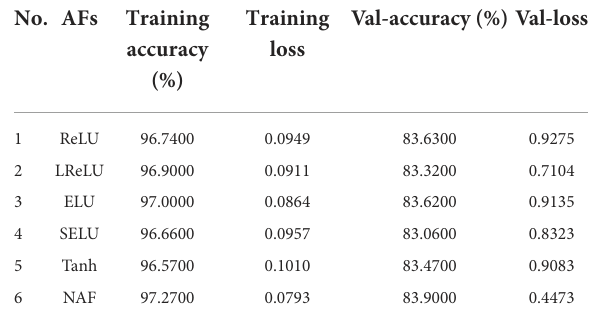
TABLE 3 SRNN model with different AFs for IMDB sentiment